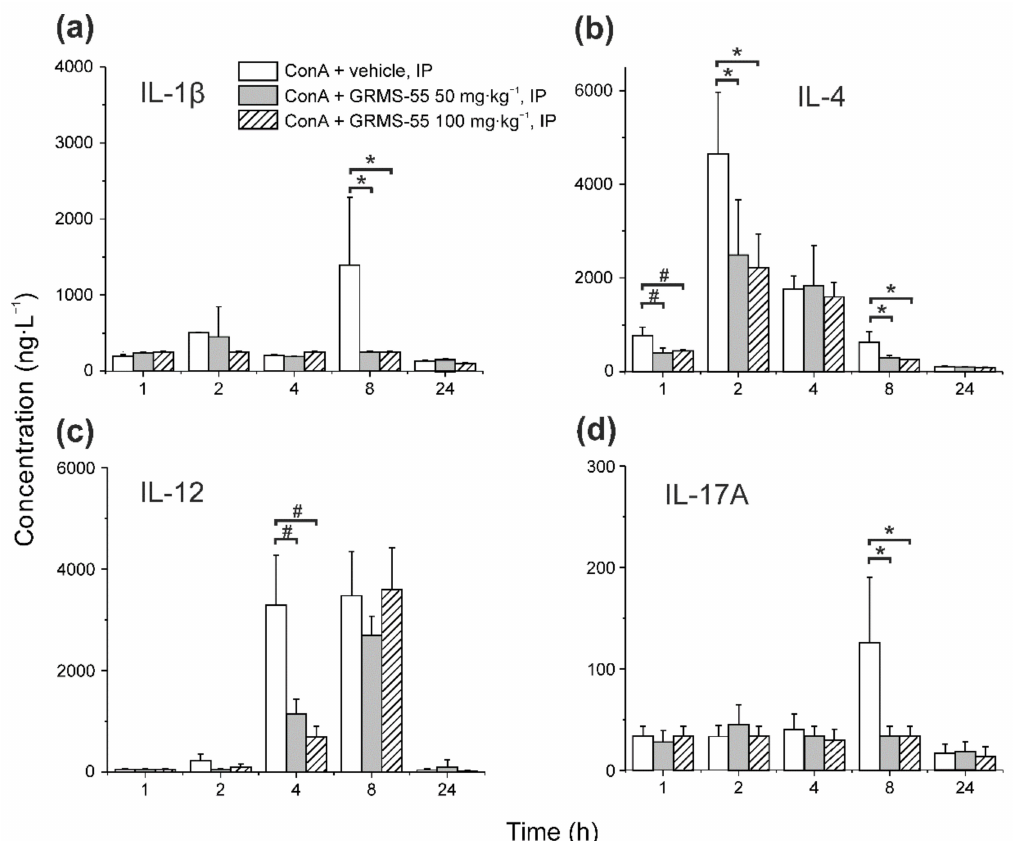
Figure 5. Influence of GRMS-55 administration at two dose levels (50 and 100 mg · kg − 1 , IP) on ( a ) IL-1 β , ( b ) IL-4, ( c ) IL-12, and ( d ) IL-17A concentrations in the serum of mice at various time points following IV administration of ConA at a dose of 20 mg · kg − 1 , IV. Each bar represents the mean (+SD) concentration of interleukin in the mouse serum ( n = 4–5). * p < 0.05, # p < 0.01, a one-way ANOVA with Tukey’s HSD post-hoc